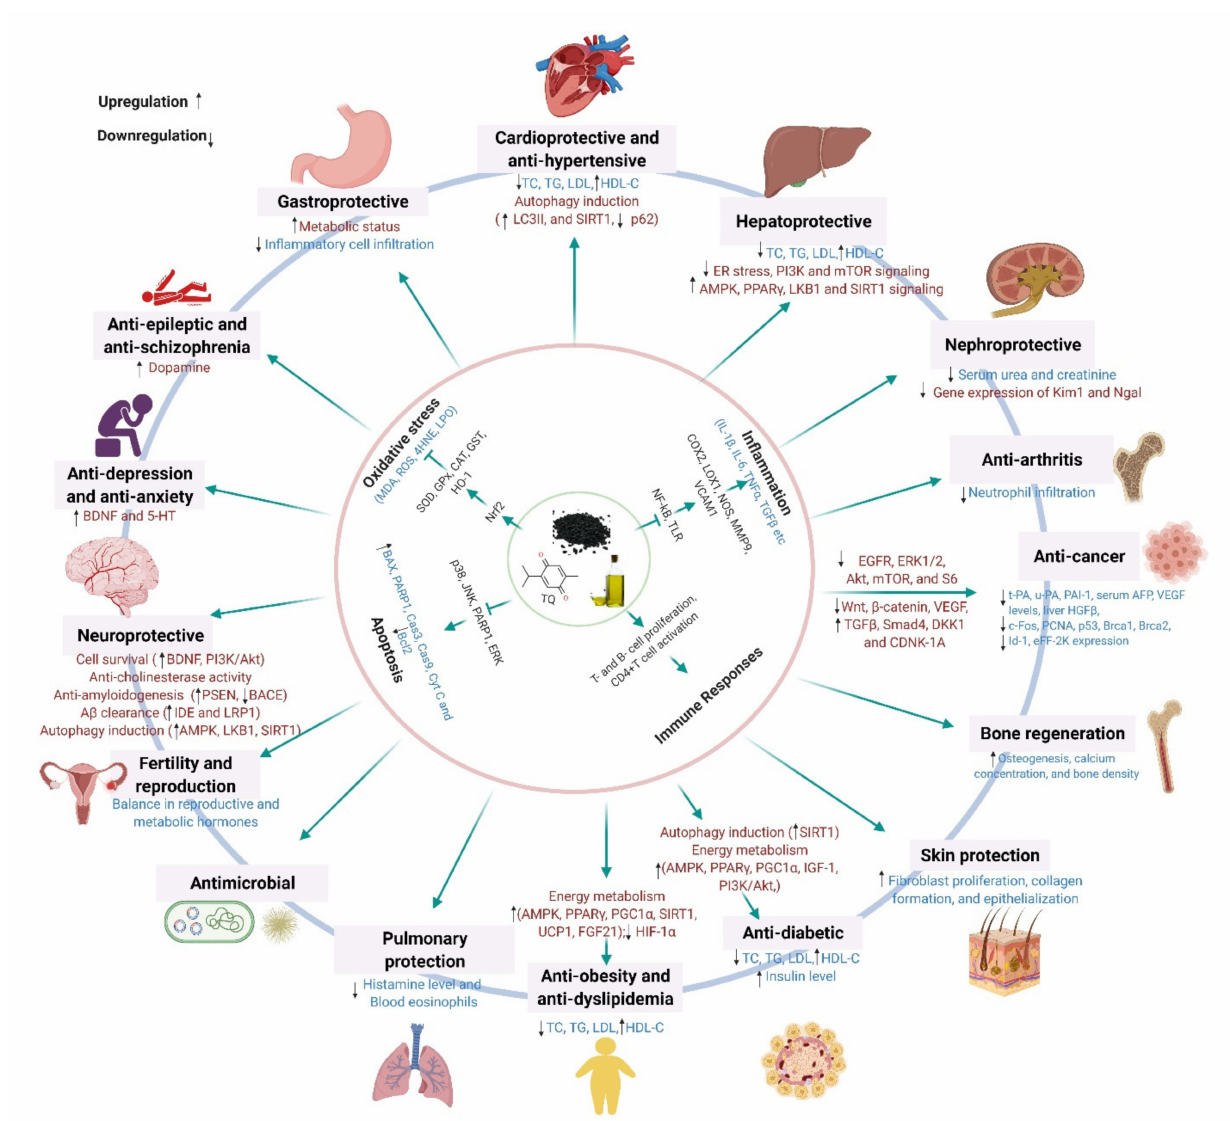
Figure 6. Comprehensive molecular mechanism of black cumin and TQ-mediated pharmacological actions. The general pharmacological effects are manifested by their capacity to attenuate oxidative stress by activating the antioxidant defense system (Nrf2 signaling), inhibit inflammation by activating anti-inflammatory signaling (NF- κ B and TLR signaling), induce immunity by modulating innate and adaptive immune components, prevent apoptosis by upregulating pro-survival signals and downregulating pro-apoptotic signals (PI3K/Akt, JNK, and mTOR signaling). Other significant molecular mechanisms include induction of autophagy (SIRT1 signaling), priming of energy metabolism (AMPK-SIRT1-PGC-1 α and PPAR γ signaling), activation of growth factor signaling (PI3K/Akt signaling), and enhancement of protein clearance by upregulating LRP1. Through employing multiple of these pharmacological mechanisms, black cumin and TQ exerted their health benefits including protection against metabolic (obesity, dyslipidemia, and diabetes), cardiovascular, digestive, renal, hepatic, osteogenic, respiratory, reproductive, neurological and mental disorders, and various types of